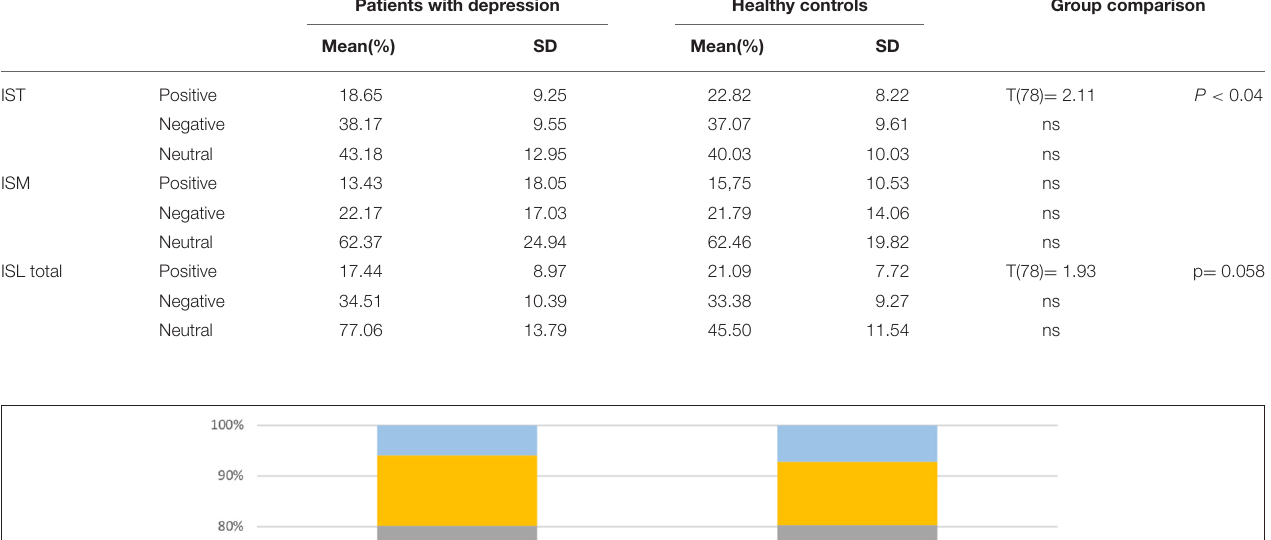
TABLE 3 | Valence of Internal State Language produced in the elicited speech production task: group comparisons. Patients with depression Healthy controls Group comparison